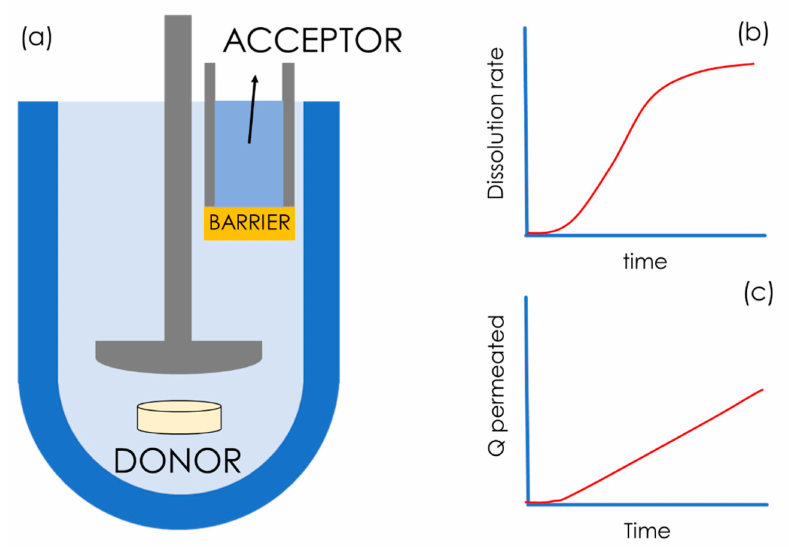
Figure 14. Schematic representation of a dissolution-absorption apparatus ( a ), e.g., macroFLUX, bioFLUX, and Dissoflux. Solid dosage forms are placed in the donor compartment, i.e., a dissolution vessel, under paddle stirring. The drug concentration is monitored in the donor and acceptor compartments, allowing the user to create dissolution vs time profiles ( b ) and drug permeated vs time profiles ( c ), respectively. In such set-ups, high mechanical and chemical stability of the barrier over time are